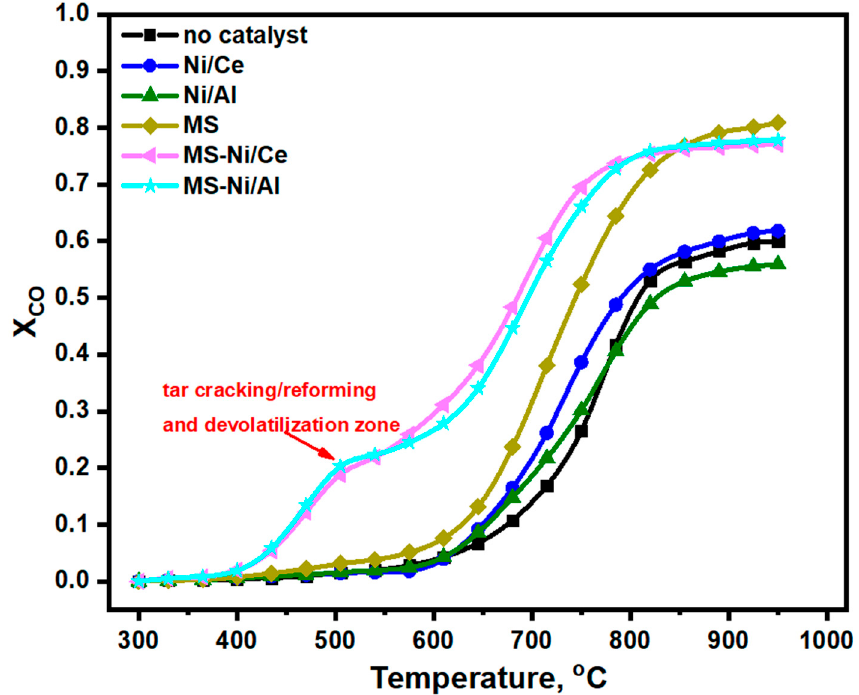
Figure 6. Effect of temperature and catalyst addition on the conversion of carbon to CO during non-isothermal CO 2 gasification experiments. Gasifying agent flowrate = 30 cm 3 /min of 20 vol.% CO 2 in Helium.